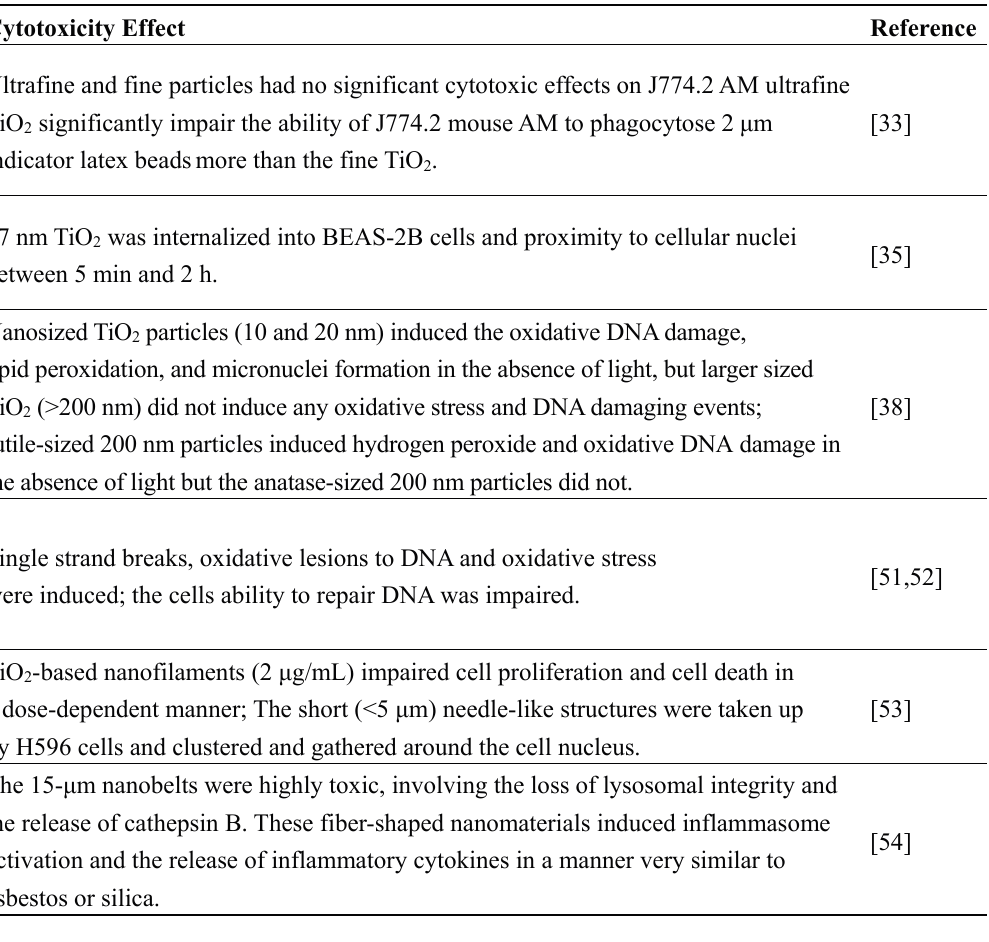
Table 2. Cytotoxicity of TiO 2 particles with different structural